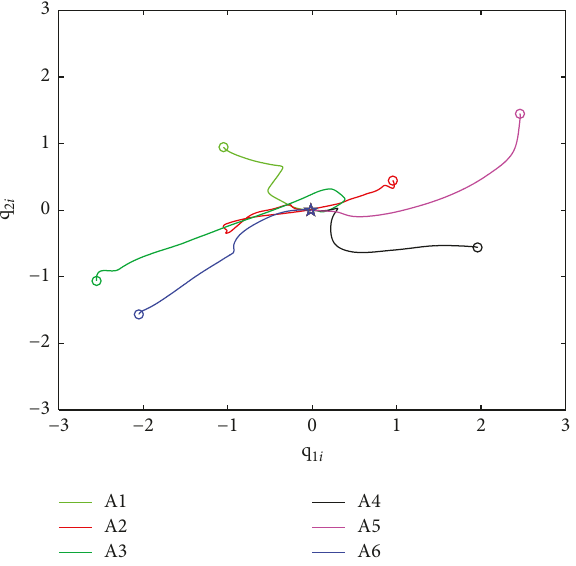
and q and the fault-free 1 i 2 i